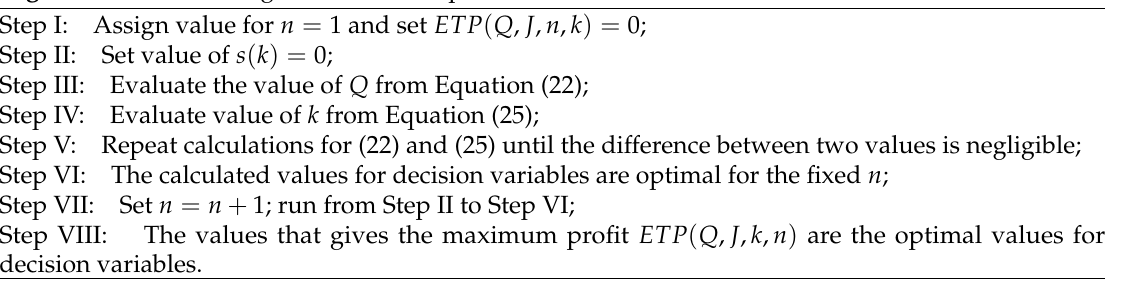
Algorithm 2 Solution algorithm to find optimal results for centralized